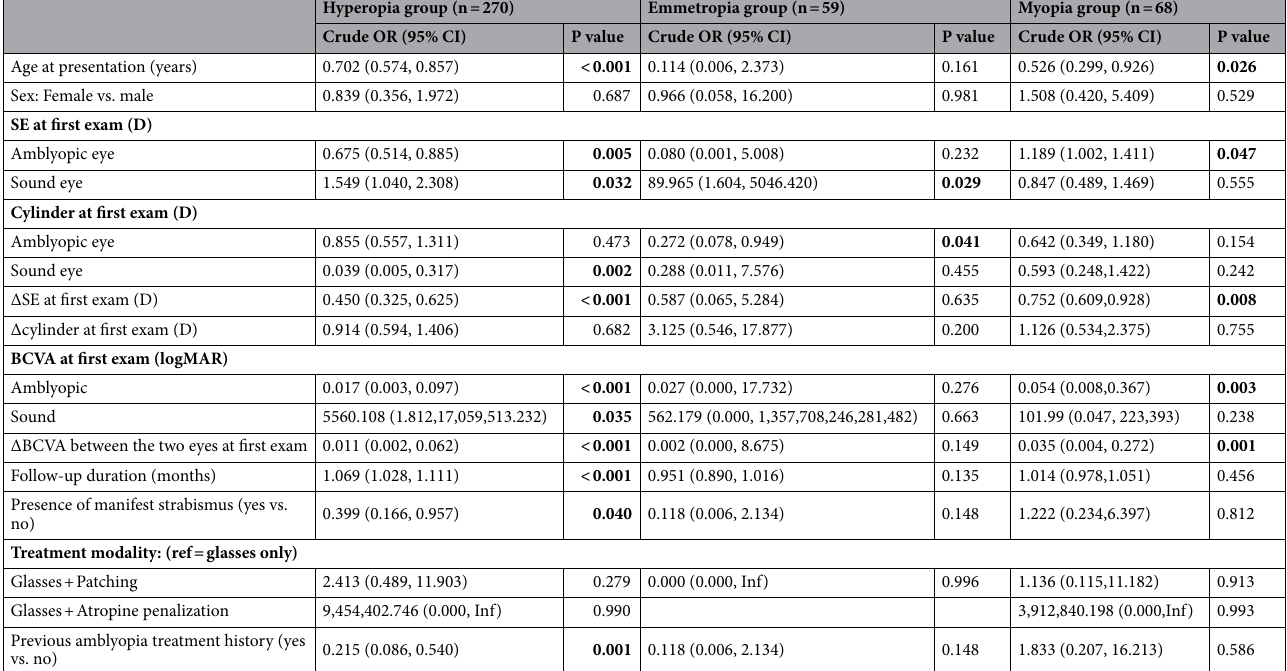
Table 2. Crude odds ratio values of factors influencing amblyopia treatment success during follow-up in hyperopia, emmetropia, and myopia groups. Cylindrical error was described as negative values. Numeric values are expressed as mean ± SD, and categorical variables are expressed as number (%). OR odds ratio, CI confidence interval, D diopter, SE spherical equivalent; BCVA best-corrected visual acuity, inf infinity, ref reference level, ΔSE difference of SE between the two eyes, ΔCyl difference of cylinder between the two eyes. *P-value < 0.05 is considered statistically significant and displayed in